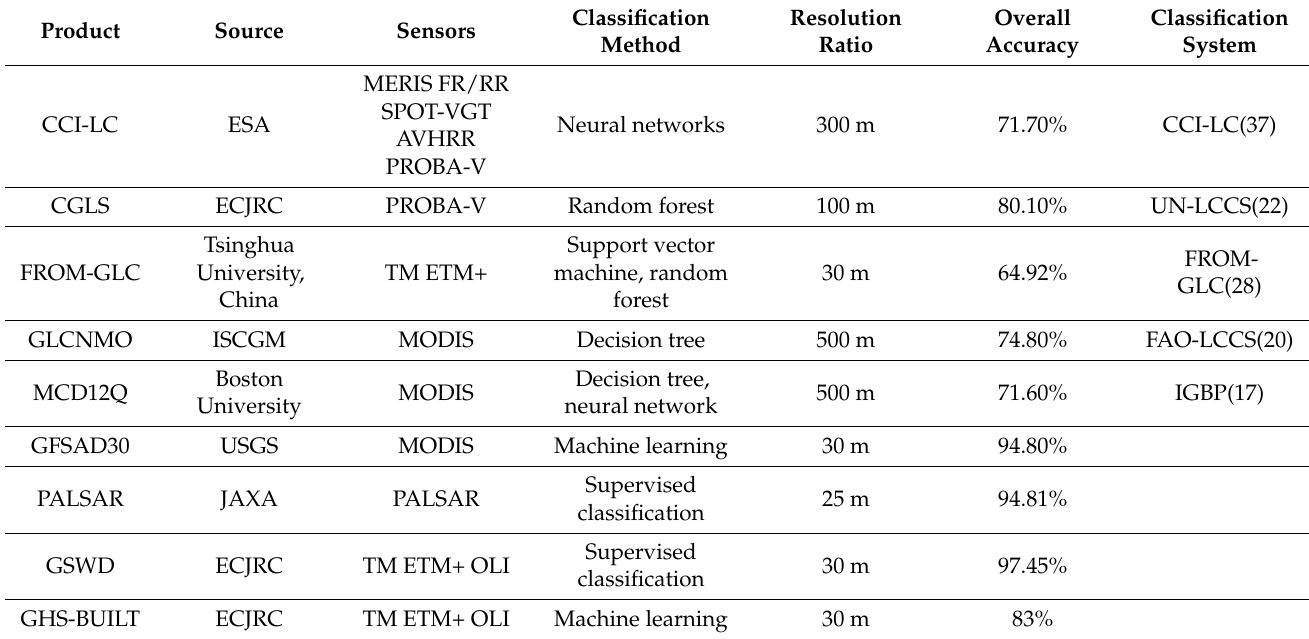
Table 1. Basic information on nine landcover products.